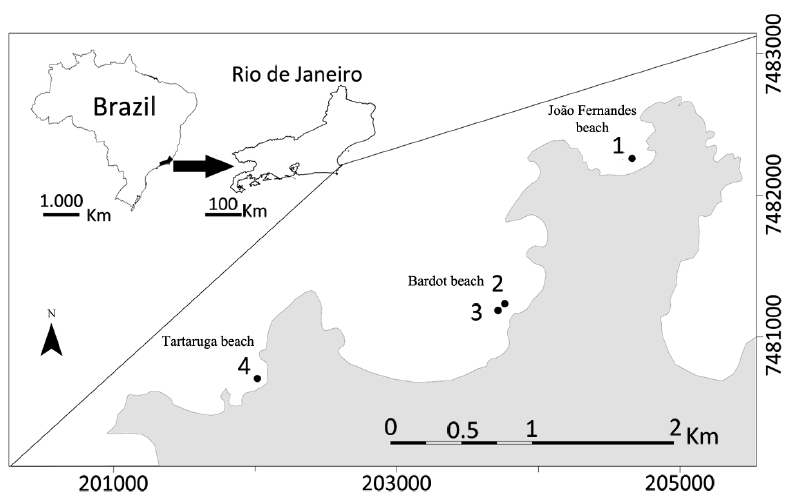
Figure 1. Study area. Armação dos Búzios rocky shore, Rio de Janeiro. Monitoring areas of coral colonies (1, 3 and 4). Recruiting experiment in an area without coral (2) and coral dominated